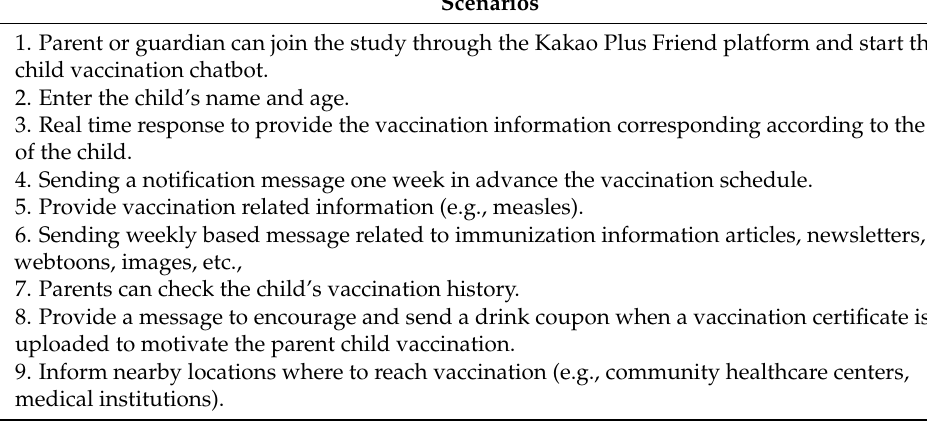
Table 2. Child vaccination chatbot’s service